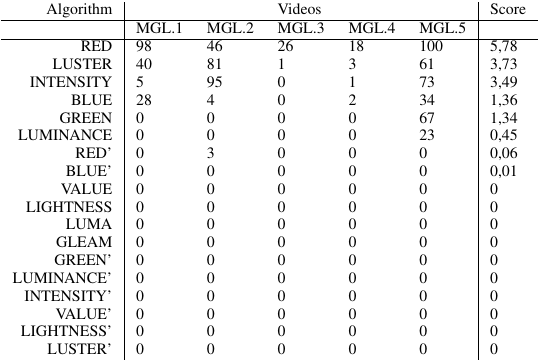
T EMPLATE 4: % OF TRACKED FRAMES AND THE SCORE PROPOSED